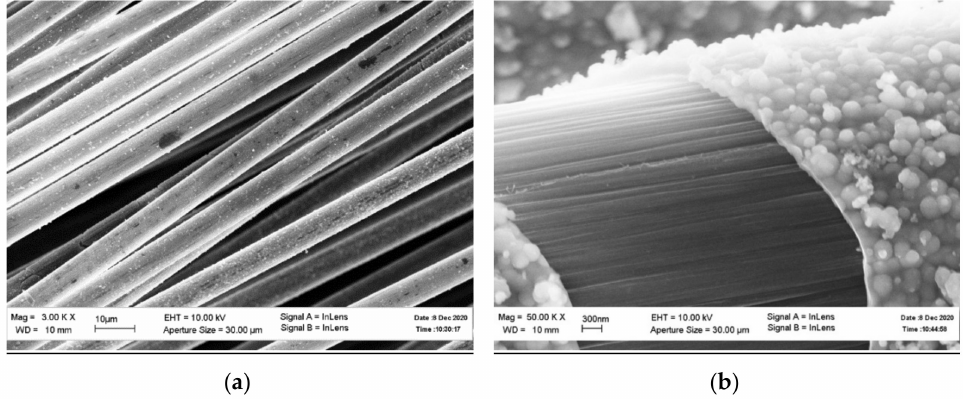
Figure 2. Representative images of the coated fiber. Magnification of ( a ) 3000 × , ( b ) 50,000 ×